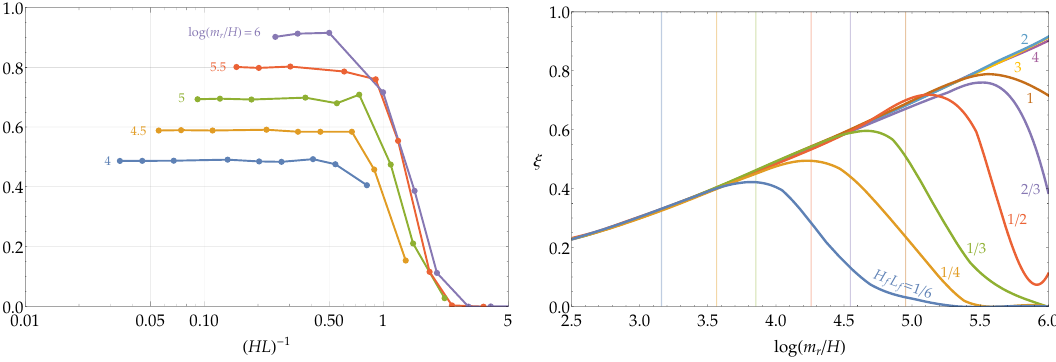
Figure 17 . Left: the extrapolation of (cid:24) ( t ) to the in(cid:12)nite box size limit, ( HL ) (cid:0) 1 ! 0. The value ( HL ) (cid:0) 1 = 1 = 2 seems to have already converged, with better than percent level accuracy at most times. Right: (cid:24) ( t ) calculated in simulations with di(cid:11)erent box sizes (measured by H f L f ); vertical lines indicate the times at which HL = 2 in each